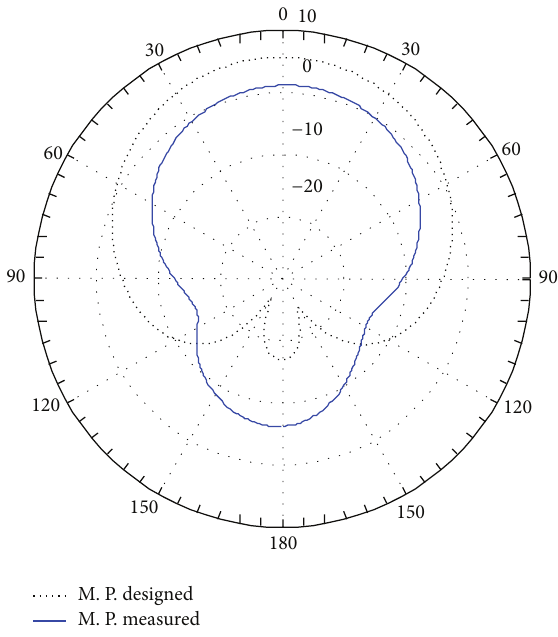
Figure 9: Simulation and measurement results for 𝐻 -plane gain of miniaturized patch with longer feed line (frequency: